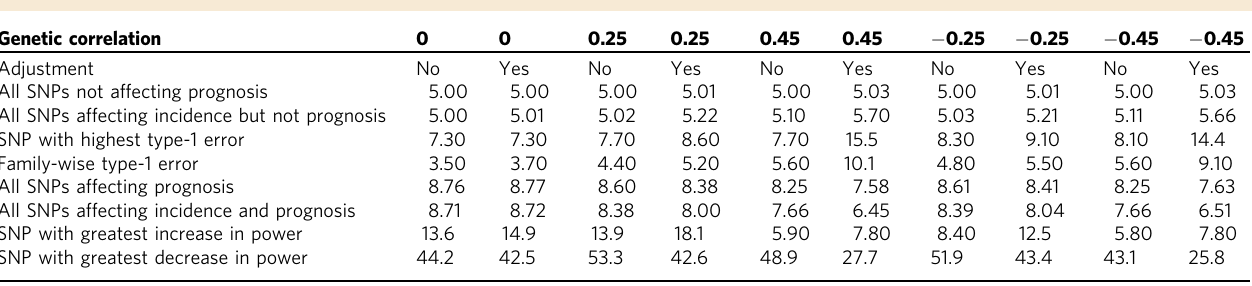
Table 4 Power for binary incidence and prognosis without non-genetic confounding Genetic correlation